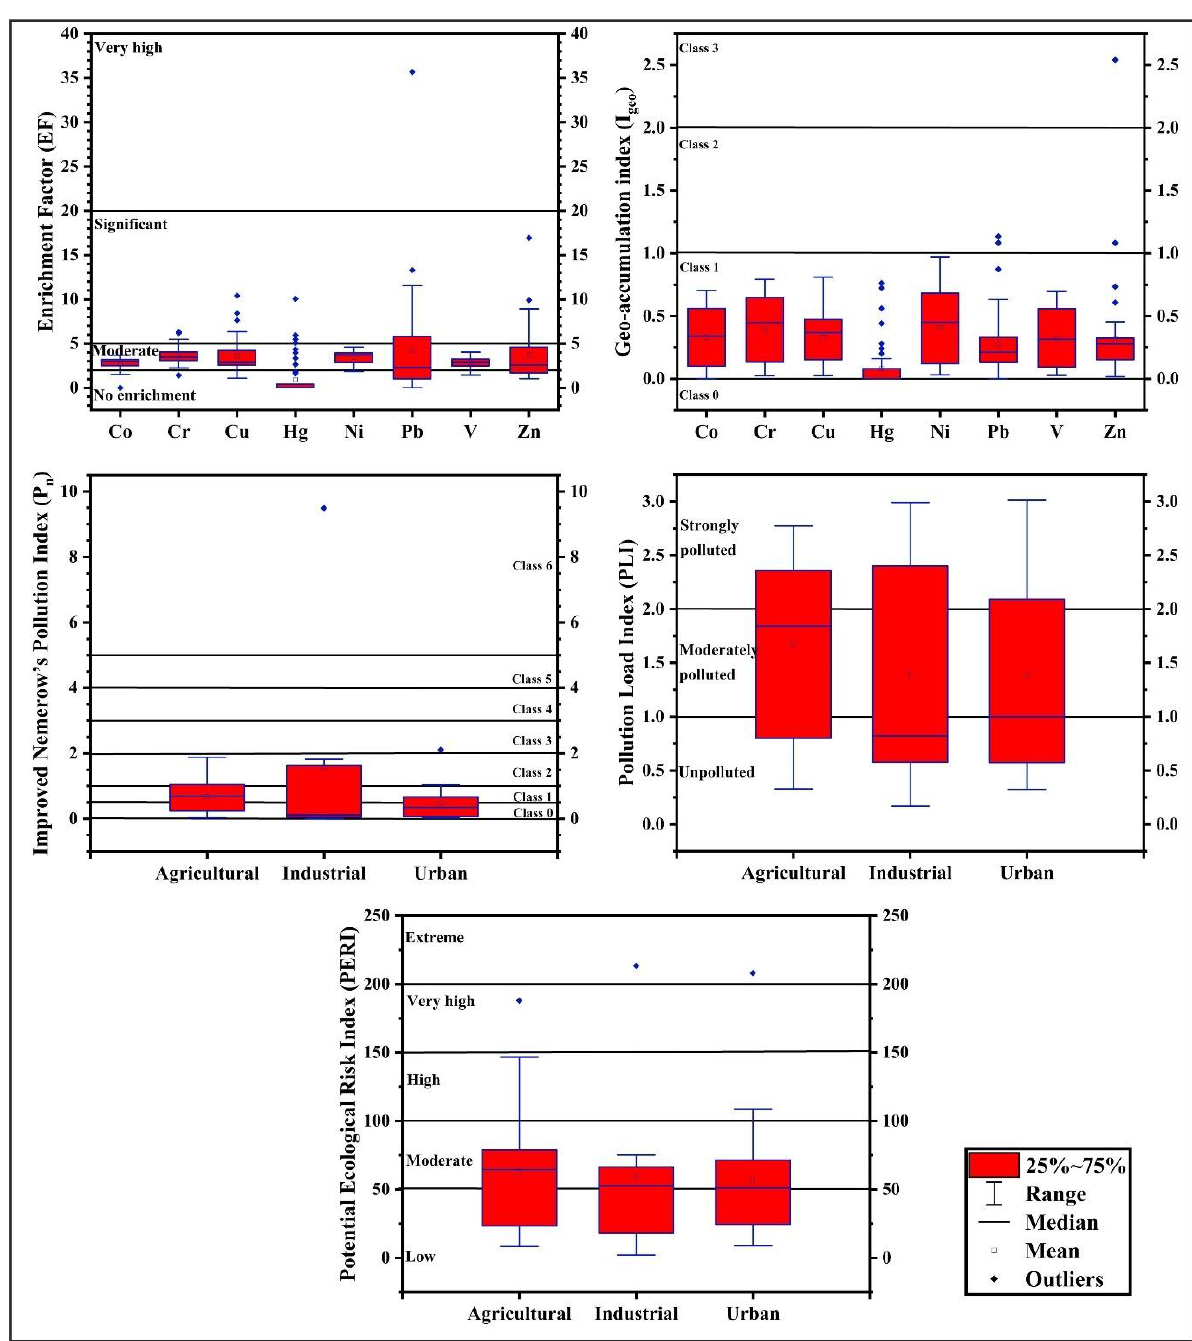
Figure 5. Boxplots of EF, I geo , P n , PLI, and PERI values.